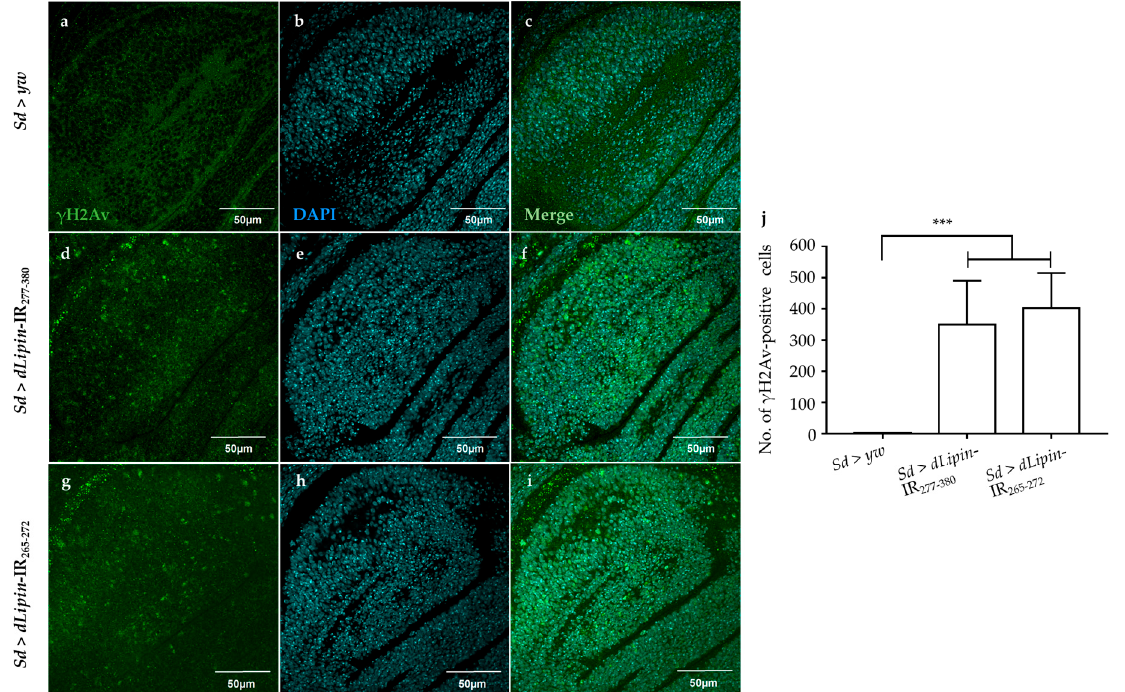
Figure 6. Knockdown of dLipin causes DNA damage in the wing pouch. Control and dLipin -kd wing imaginal discs were stained with DAPI to visualize the DNA ( b, e, h ) and mouse anti- γ H2Av antibody followed by anti-mouse IgG Alexa Fluor TM 488 antibody ( a, d, g ). Merged images of DAPI and anti- γ H2Av antibody staining ( c, f, i) . The number of γ H2Av-positive cells in the wing pouch of imaginal discs of 3rd-instar larvae from control and dLipin- kd flies was analyzed using MetaMorph software ( n = 14 for each genotype) ( j ). Data are expressed as the means ± S.D. The statistical significance of the difference between control and dLipin -kd flies was evaluated using one-way ANOVA. ***, p < 0.01. Scale bar, 50 µm; IR, inverted repeat. Genotypes: Sd -GAL4/+; +; + ( a – c ), Sd -GAL4/+; UAS -dLipin- IR 277-380 /+; + ( d – f ), Sd -GAL4/+; UAS -dLipin- IR 265-272 /+; + ( g – i ).